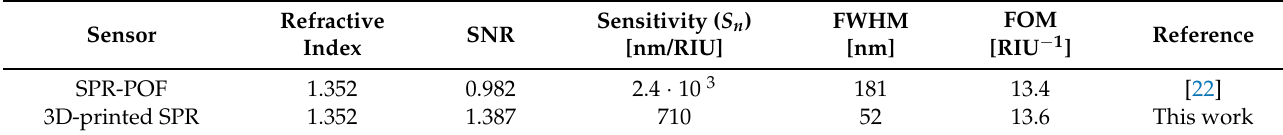
Table 2. Performances’ parameters relative to two different types of SPR sensors at a fixed refractive index equal to 1.352.